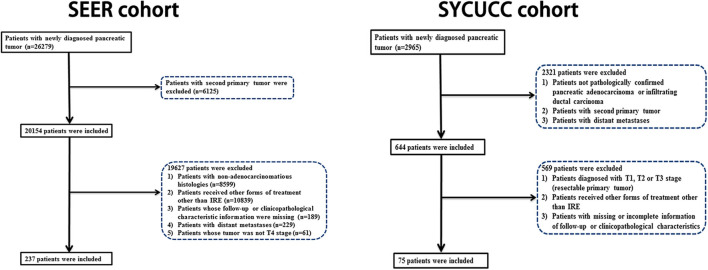
Flow diagram of the data selection process.